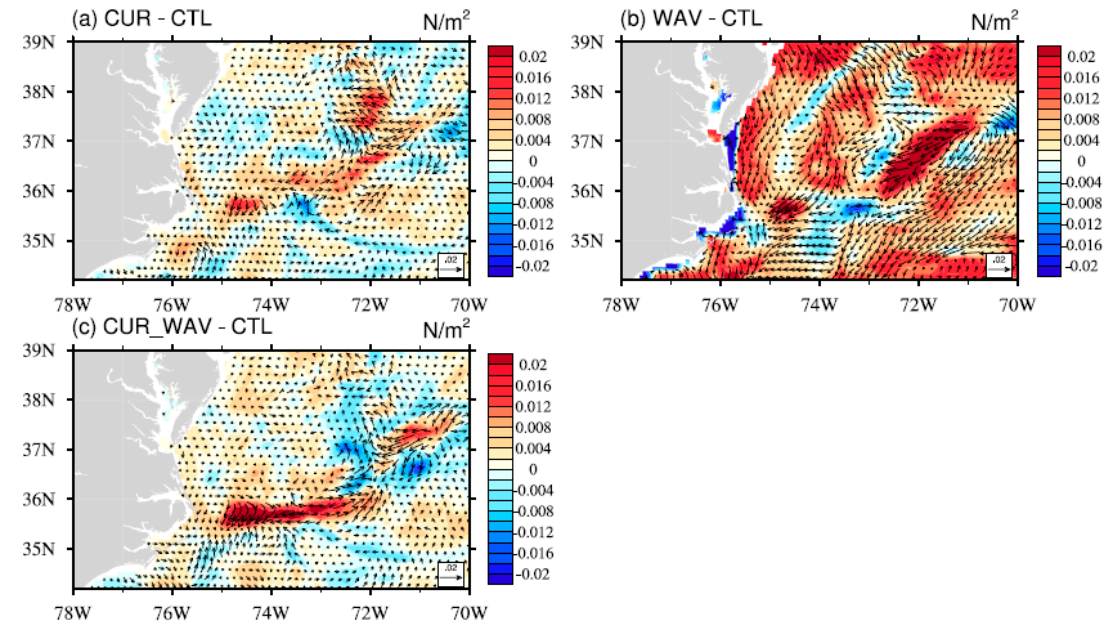
Figure 3 . Change of wind stress magnitude (color shaded, N/m2) and vector (black vectors) due to ( a ) surface currents and wind stress coupling (CUR-CTL), ( b ) waves and wind stress coupling (WAV-CTL), and ( c ) three-way coupling of the surface current, waves, and wind stress (CUR_WAV-CTL) averaged over a 30 day period.